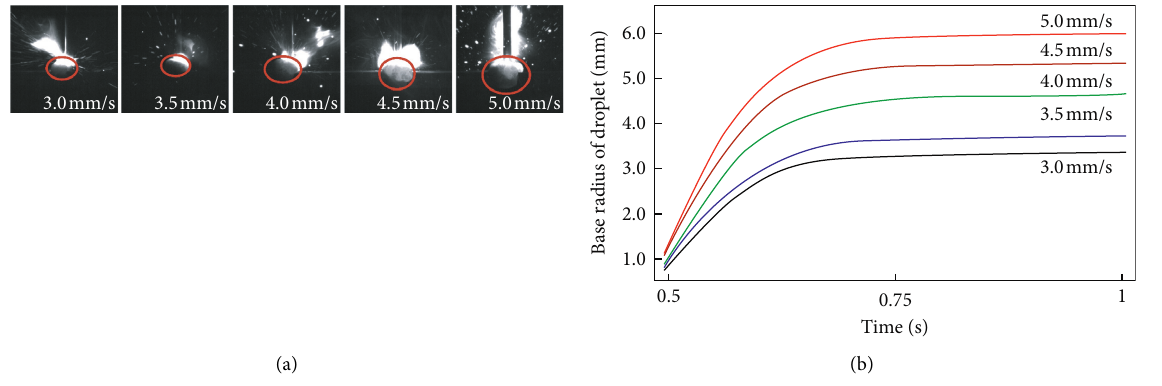
Figure 15: Predictions of the droplet spreading in different wire feed speeds.